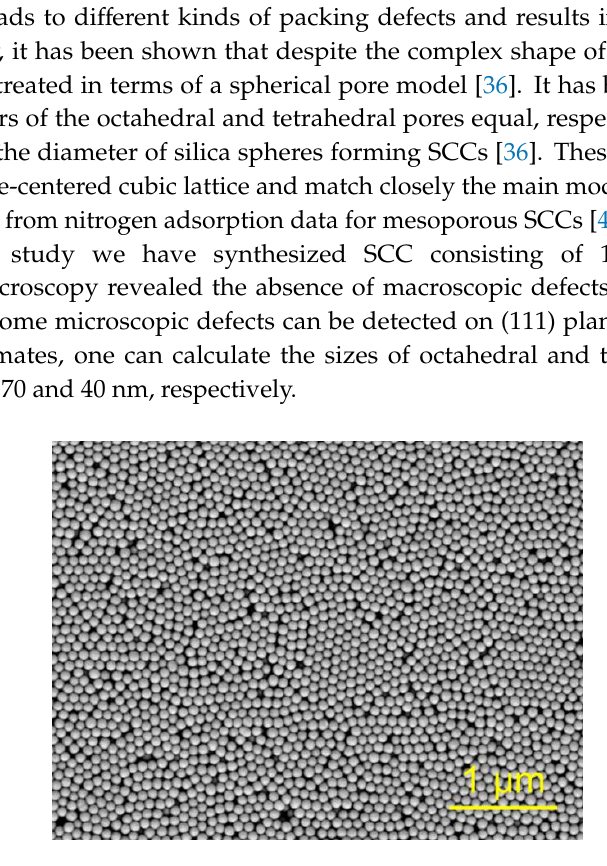
Figure 3. SEM image of (111) plane of the synthesized SCC made of 110 ± 4 nm silica spheres. Scale bar is 1 µm.